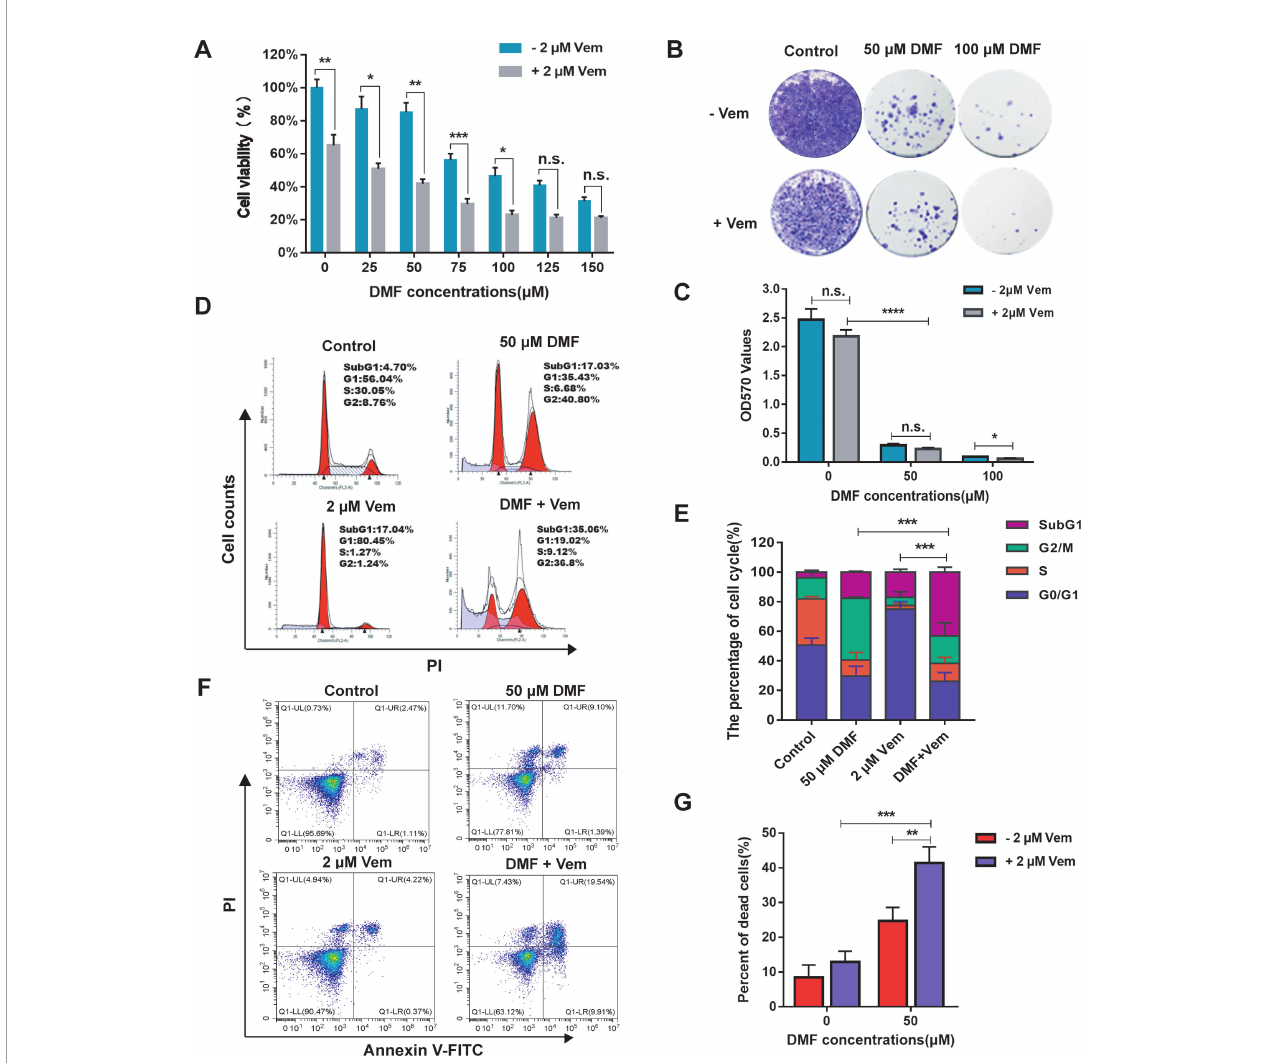
FIGURE 1 | Effects of DMF/Vem on the proliferation and cell death of melanoma cells. (A) A375 cell viability was assessed via CCK-8 assay following DMF and/or Vem treatment for 48 h (n = 5), with data being shown as the percentage of absorbance at 450 nm relative to controls. (B) Representative images of A375 cell colonies stained with crystal violet following treatment with DMF with or without 2 m M Vem for 15 d. (C) Quanti fi cation of the data from (B) . (D) Representative cell cycle distribution pro fi les for A375 cells treated with the indicated DMF and Vem doses for 24 h followed by PI staining and fl ow cytometry analysis. (E) Quanti fi cation of the data from (D) . (F) Flow cytometry-based assessment of A375 cell death following treatment with 50 m M DMF and/or 2 m M Vem as measured by PI-Annexin V double staining. (G) Quanti fi cation of cell death data from (F) . All numerical data were from at least three independent experiments and shown as mean ± SD. * P < 0.05, ** P < 0.01, *** P < 0.001, **** P < 0.0001 vs. DMF or Vem treatment, n.s., not signi fi